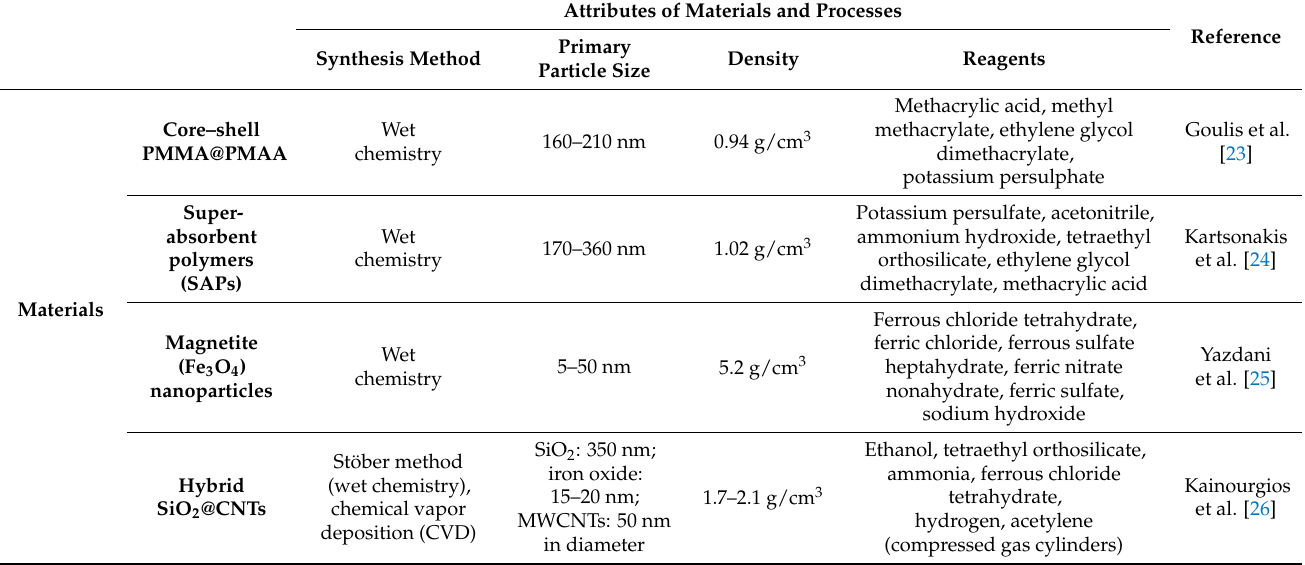
Table 1. Basic characteristics of the studied materials and their processes. Attributes of Materials and